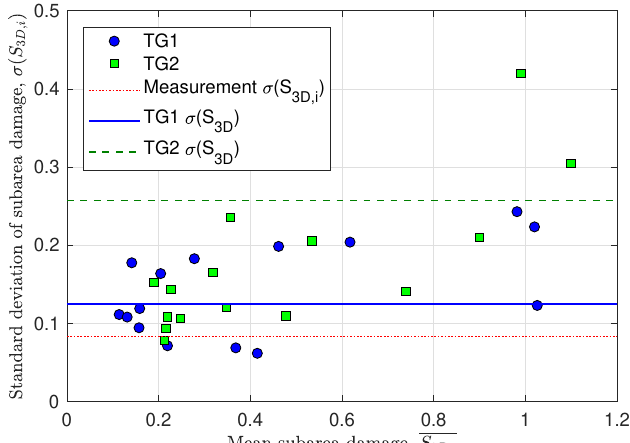
Figure 15. Relationship between the mean subarea damage S 3 D , i and the standard deviation σ ( S 3 D , i )